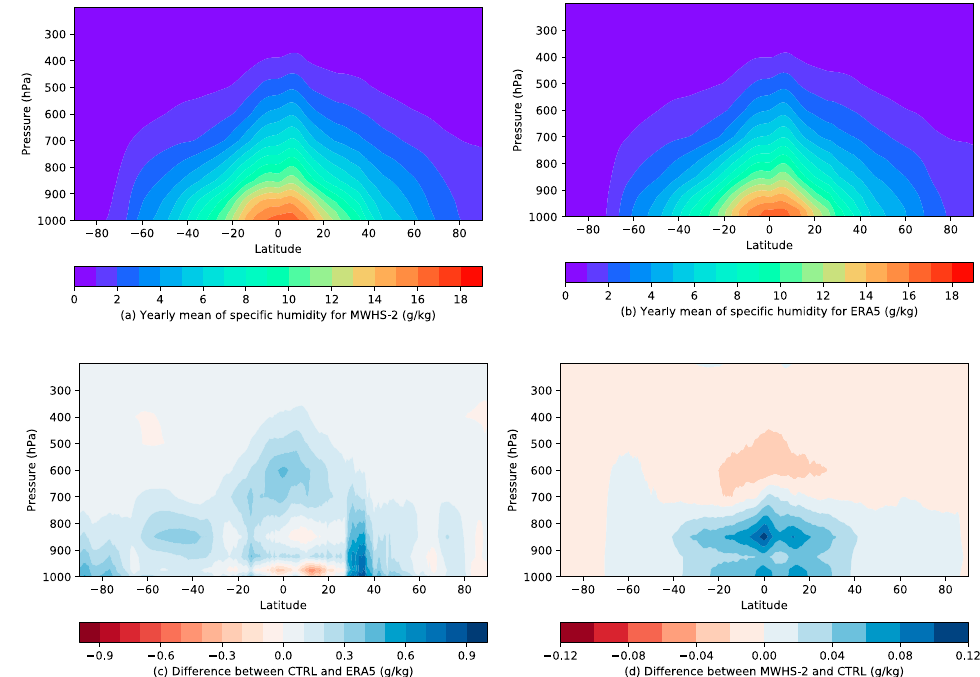
Figure 4. Zonal-mean cross-section of yearly mean (from August 1, 2016 to August 31, 2017) specific humidity analysis for the “MWHS-2” experiment ( a ) and (ERA5) ( b ) and the di ff erences between “CTRL” and ERA5 ( c ) and also the di ff erences between “MWHS-2” and “CTRL” ( d